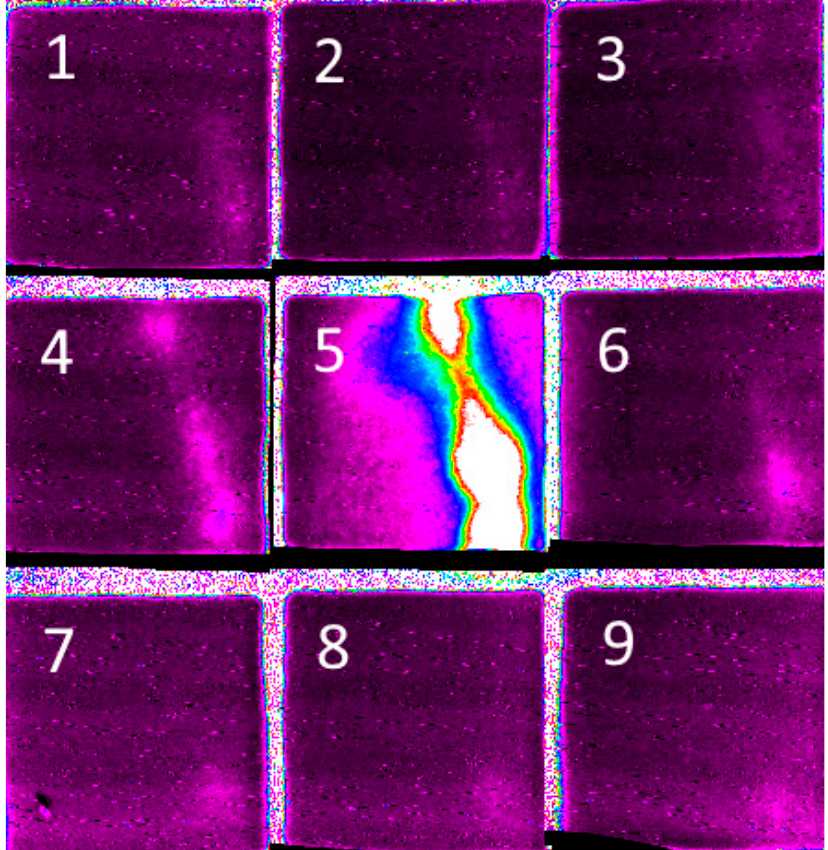
Figure 6. Characteristic oscillogram of the first and repeated discharge current pulses (blue signal) between a single artificial positively charged thundercloud cell and the ground involving two groups of model hydrometeors and signals, registered by antennas A1-A3 (red, green and magenta signals resp.).